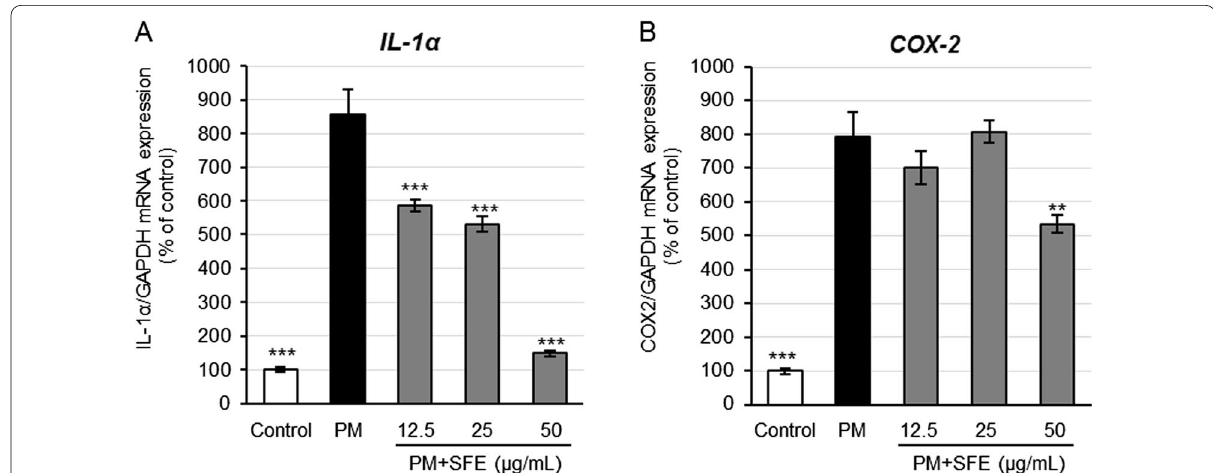
Fig. 4 Inhibitory effects of SFE on IL‑1α and COX‑2 mRNA expression in PM‑stressed keratinocytes. NHEKs were treated with SFE in the absence or presence of PM for 6 h at 37 °C. Each mRNA expression in the cells was examined by qRT‑PCR. Inhibitory effects of SFE against PM‑induced IL‑1α ( A ) and COX‑2 ( B ) mRNA expression in the cells. Bars represent mean